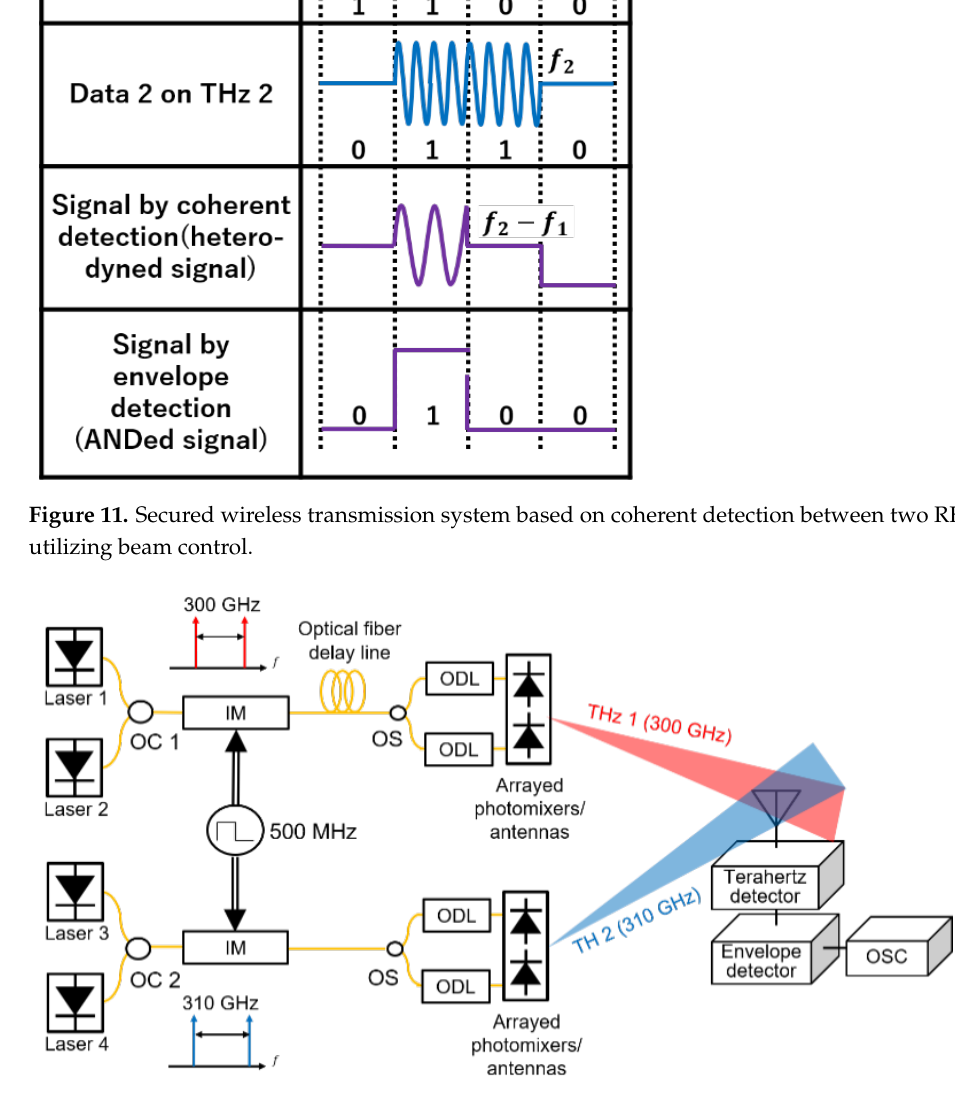
Figure 13. Observed waveforms of THz 1 ( upper ), THz 2 ( middle ) and THz 1 + THz2 ( lower ). 6. Discussion The arrayed terahertz-wave generation based on photomixing showed a great impact on enhancing and concentrating the power because signals are easily copied, phase-tuned and distributed into the array in the optical domain. The experimental result showed that the peak power of the radiated terahertz wave is proportional to the square of the number of elements in the array. To tune the phase of the terahertz waves, either −(𝑘 2 𝑥 2 − 𝑘 1 𝑥 1 )